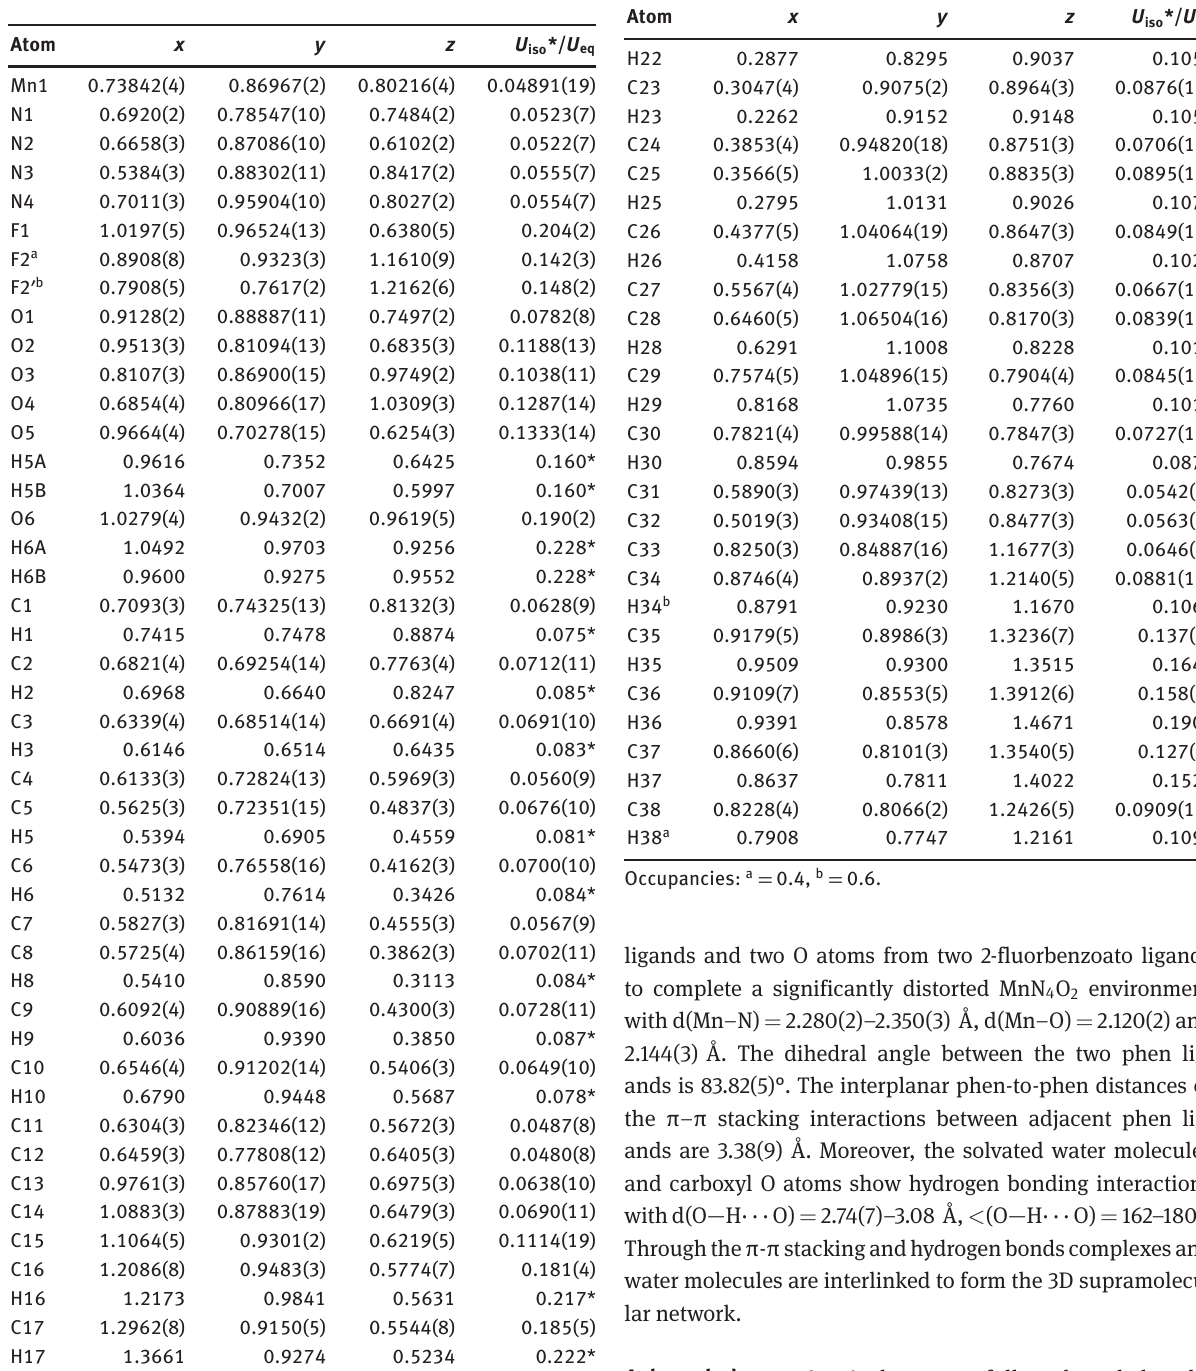
Table 2: Fractional atomic coordinates and isotropic or equivalent isotropic displacement parameters (Å 2